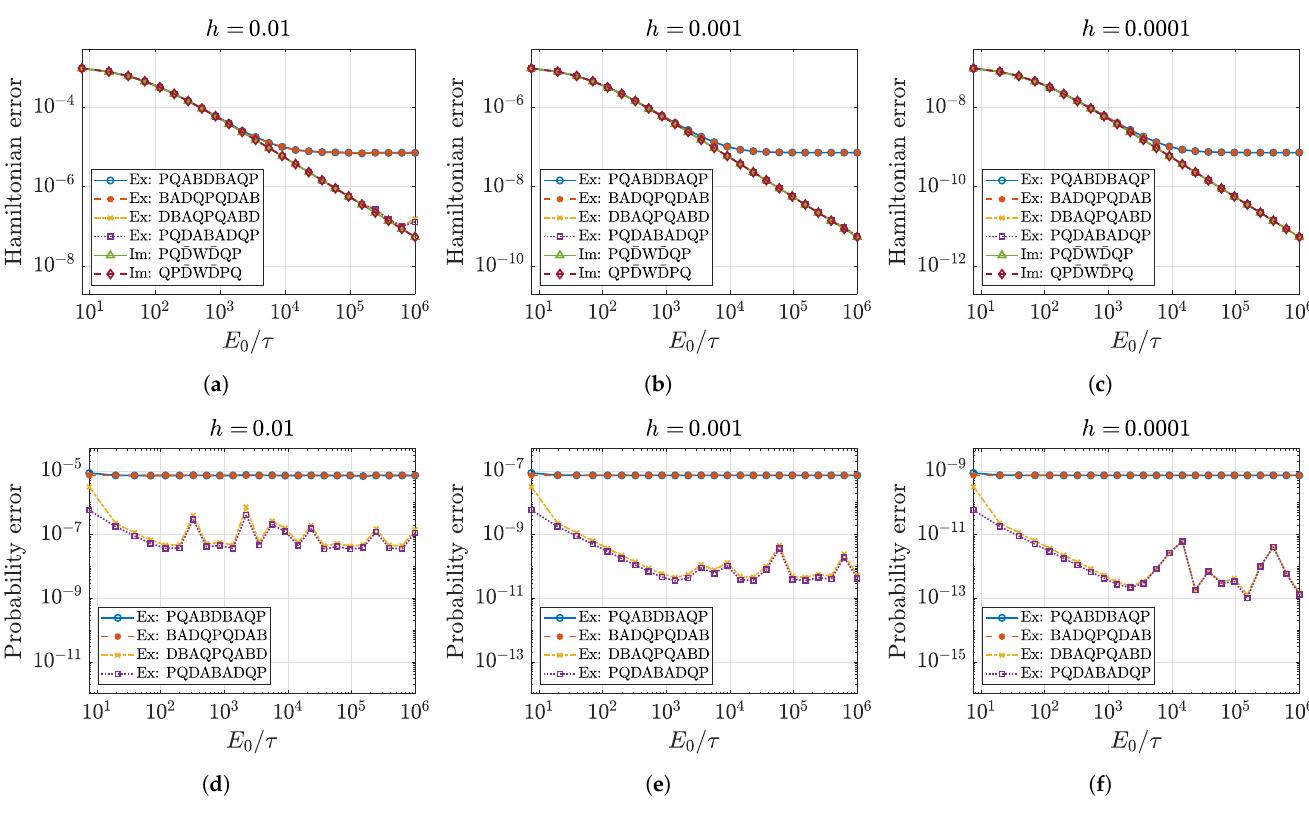
Figure 5. Hamiltonian and total probability conservation errors of the splitting methods: PQABDBAQP, BADQPQDAB, DBAQPQABD, PQDABADQP, PQ ¯DW ¯DQP, and QP ¯DW ¯DPQ. Top ( a – c ): maximal relative error of the Hamiltonian (42) for t ∈ [ 0,100 ] . Bottom ( d – f ): maximal relative error of the total charge probability (16) for t ∈ [ 0,100 ] , where the results for semi-implicit methods are excluded. Left ( a , d ): time step h = 0.01. Middle ( b , e ): time step h = 0.001. Right ( c , f ): time step h = 0.0001. The Hamiltonian and probability errors are averaged over eleven numerical simulations with randomly generated initial conditions from the uniform distribution U ( − 0.01,0.01 )